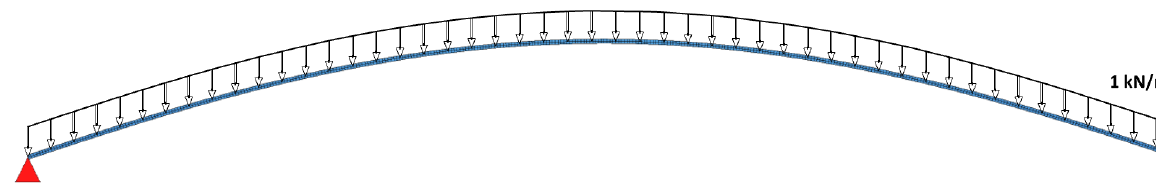
Figure 8: The geometry of the beam with initial uniform loads.